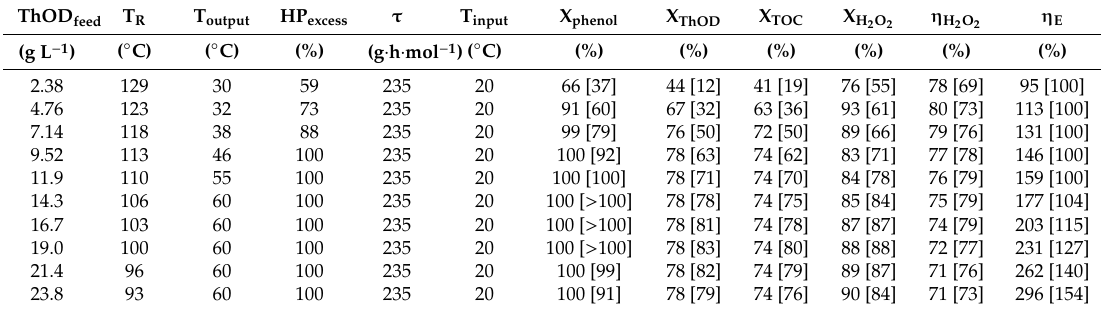
Table 5. Optimal operating conditions and corresponding response values calculated by the Aspen Plus ® v11 simulator as a function of the chemical oxygen demand flow rate fed to a CWPO unit to accomplish the multi-objective optimization of Equation (7). The values predicted by the quadratic models are in brackets.